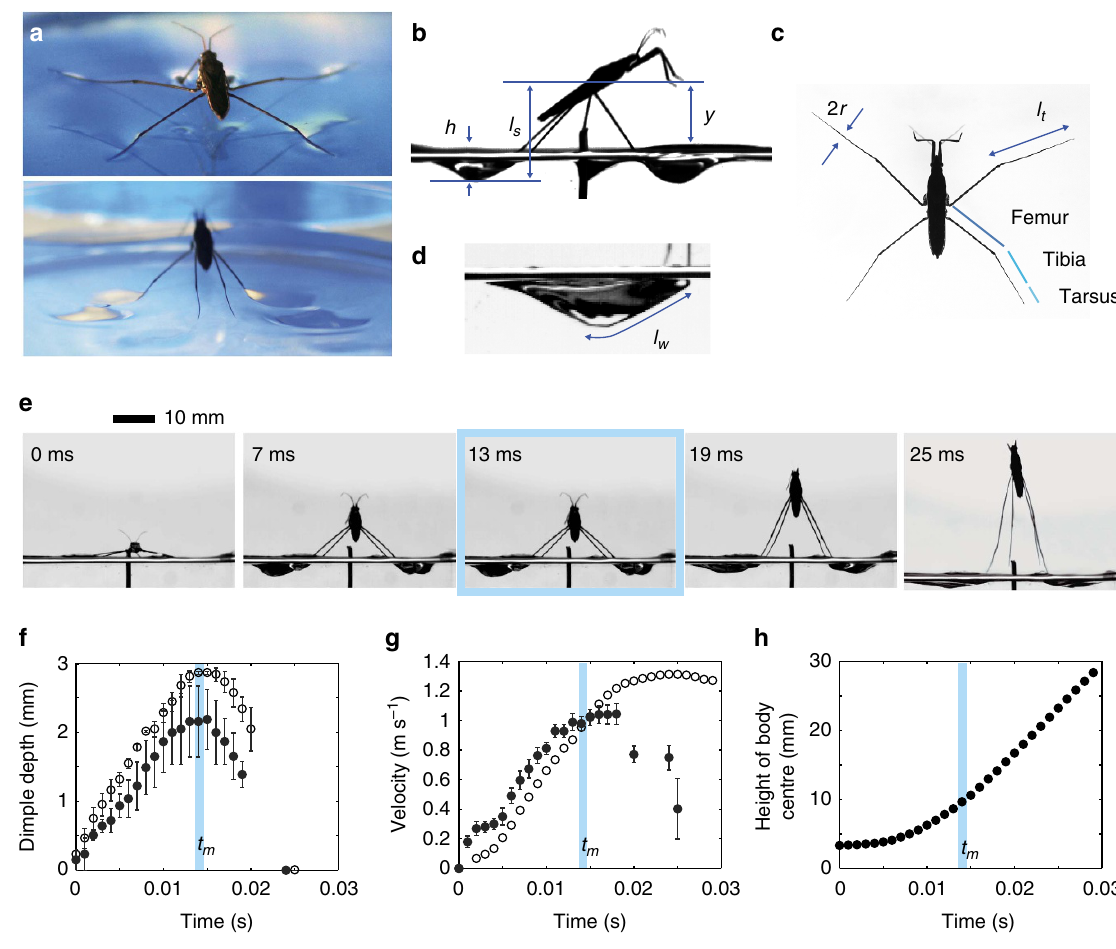
Figure 1 | Jumping of a water strider. ( a ) A water strider (male Aquarius paludum with a body mass of 37.2mg and an average length of middle and hind legs of 22.1mm) that rests and jumps on water. ( b – d ) Definitions of various lengths considered in this study. ( b ) The vertical lengths including body centre location y , vertical distance from the tip of the legs to the horizontal plane through body centre l s and dimple depth h . ( c ) The lengths of legs including the radius r , and the length of tibia plus tarsus l t . ( d ) The wetted length of the leg l w . ( e ) A representative sequence of the jump of the water strider on the water surface. ( f – h ) Measurement data extracted from a movie corresponding to e . ( f ) Average dimple depth formed by the right and left legs (open circles for middle legs, filled circles for hind legs) during the jump. Error bars indicate standard deviation between right and left legs. ( g ) Vertical velocity of the body centre n (open circles) and the average downward velocity of the four legs with respect to the horizontal plane through the body centre n s (filled circles). Error bars indicate standard deviation among four legs. ( h ) Height of the body centre of the water strider during the jump. The vertical blue bar in f – h indicates the moment when the dimple reaches the maximal depth (the panel corresponding to 13ms in e shows the dimple that reached maximal depth). Body velocity profile in g is the same data as that of water strider 2 in Koh et al.